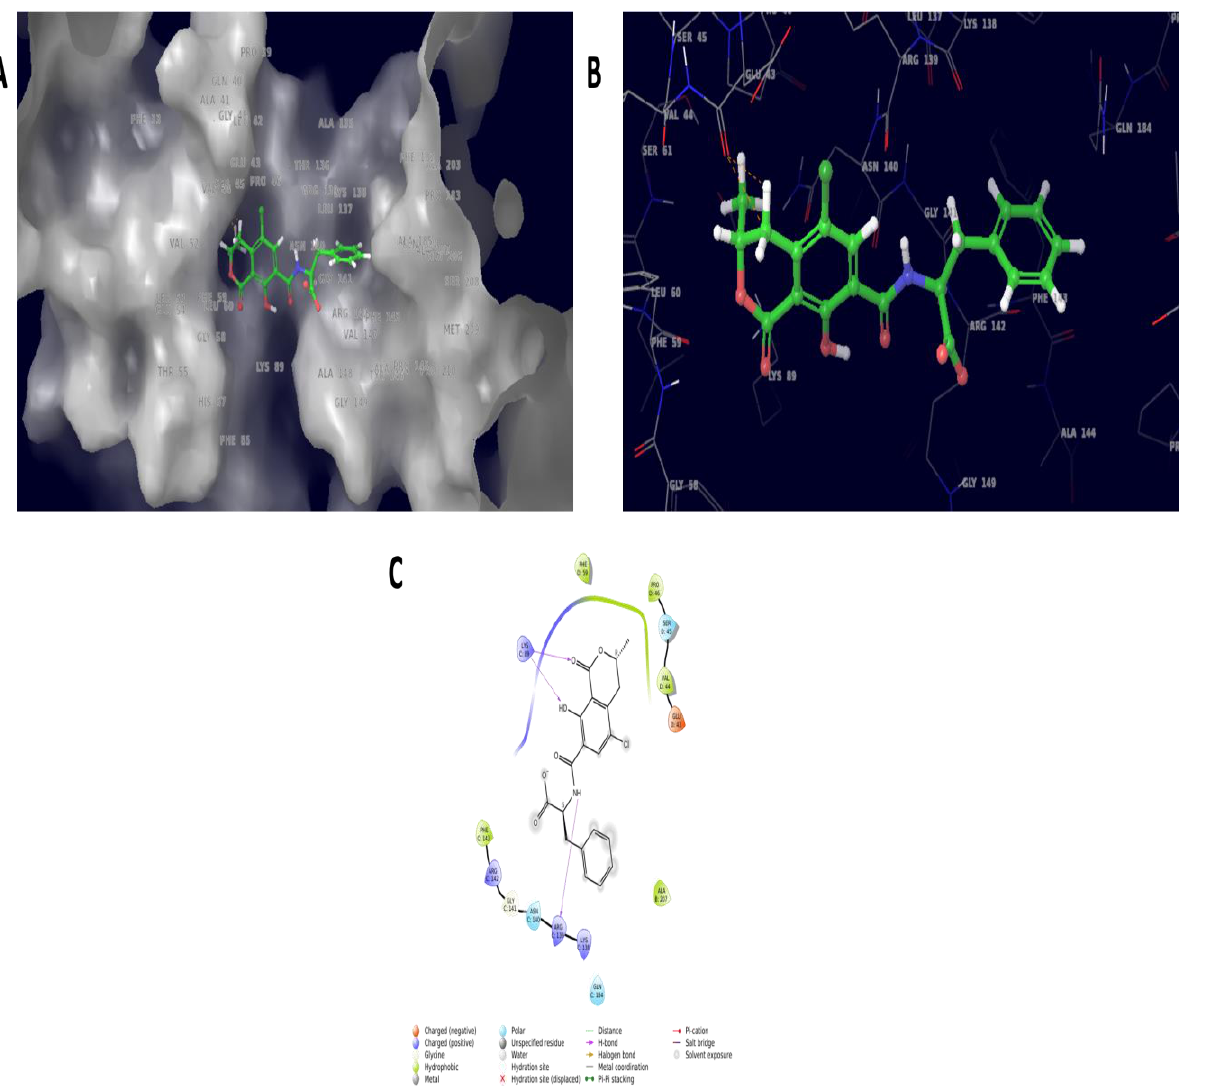
Figure 9. The docked complex molecule of glutathione s-transferase shows 3D pocket binding sites ( A ), the three-dimensional structure of molecular interactions ( B ) and the two-dimensional interaction diagram ( C ). These enzymes interacted with the amide bond and epoxide moiety of the ochratoxin compound, which could be a possible site for degradation or detoxification mechanisms.